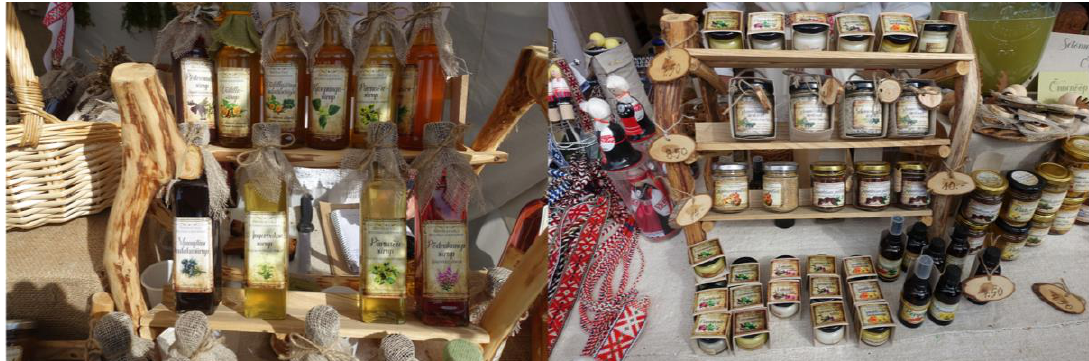
Figure 6. Seto Kingdom Day on 5 August 2018 in Lüübnitsa village. A selection of products from small local producers in Setomaa. Kingdom Day is one of the most important events in the region where home-produced products are traded. Photos: Renata Sõukand.